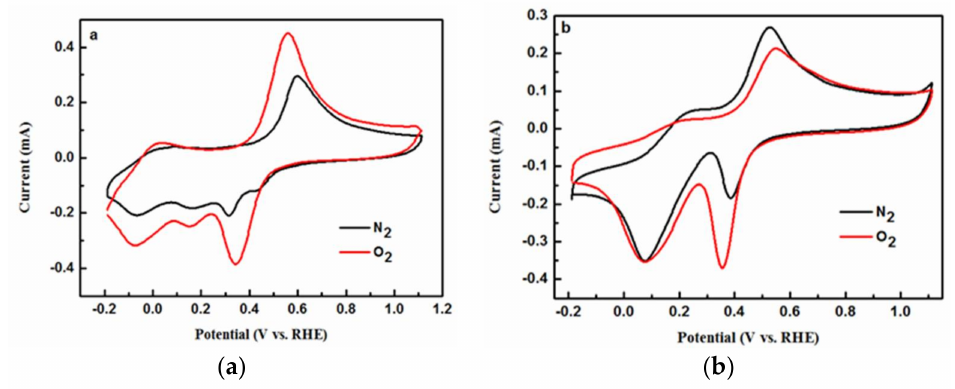
Figure 11. Cyclic voltammetry (CV) of Complex 1 in PBS saturated with N 2 and O 2 ( a ), CV of Complex 2 in PBS saturated N 2 and O 2 ( b ). Scan rate: 100